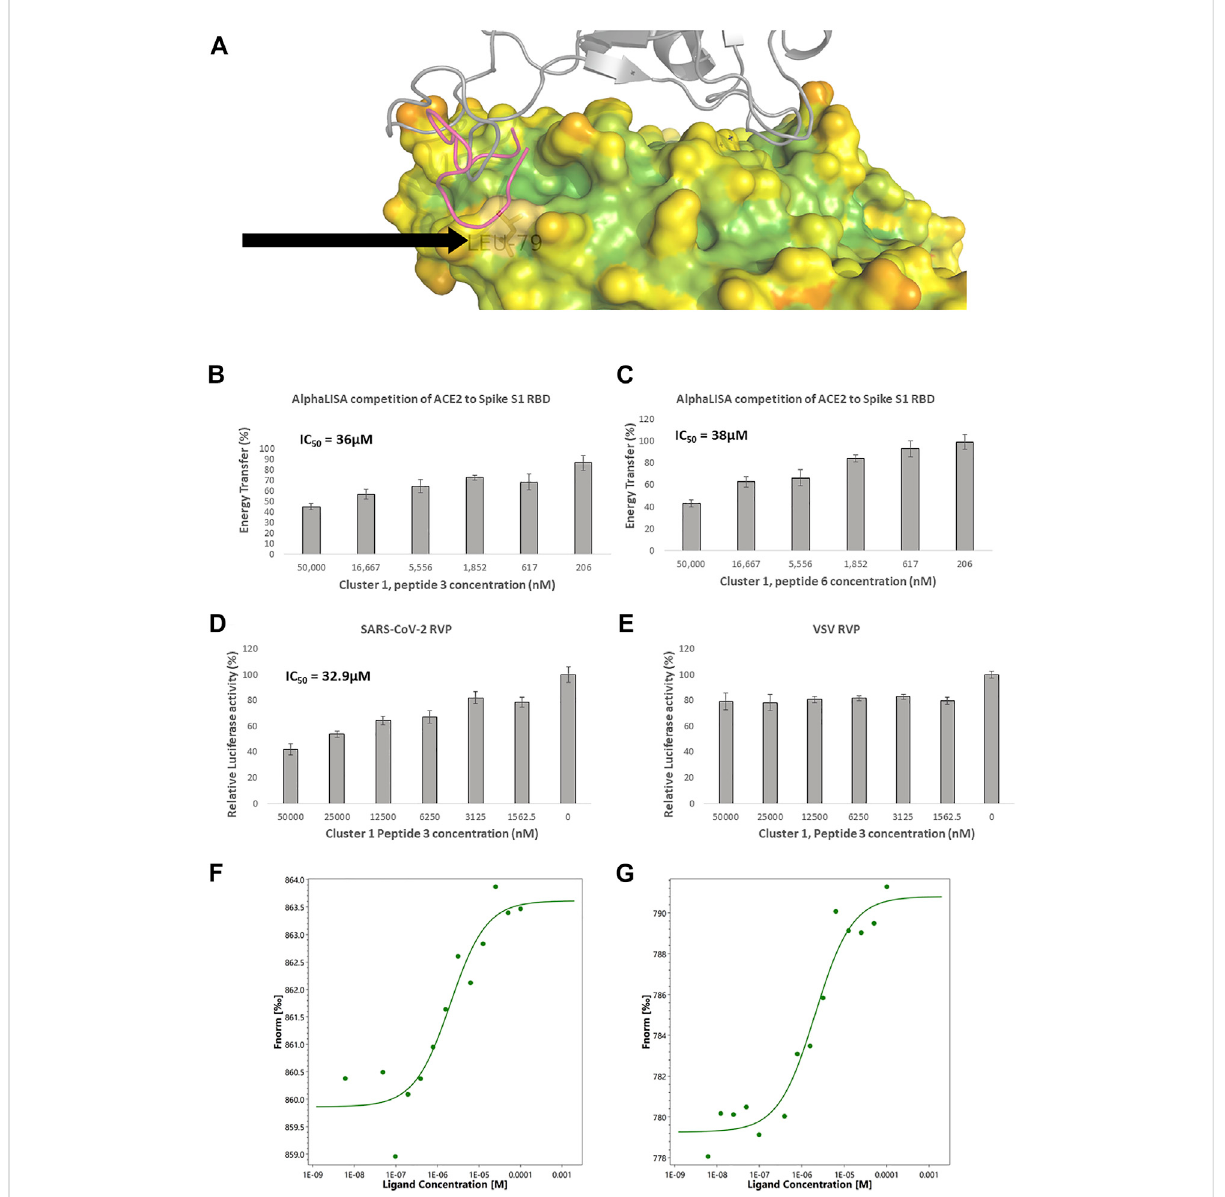
FIGURE 2 Competitive ACE2 targeted screening. (A) A heat diagram analysis of RBD surface concavity (PDB: 6VW1, chain A), (blue = concave, red = convex), spike RBD is shown as a grey cartoon. Leucine 79, chosen as the center of the screening grid, is shown with the black arrow. Cluster 1, peptide 3 docking model is shown as purple cartoon. AlphaLISA analysis was used to detect the interaction between the spike protein and the hACE2 receptor. Characterization of inhibitory effect on the interaction between spike and hACE2 proteins. IC50 was calculated for (B) Cluster 1,peptide3and (C) cluster1peptide6( n =2biologicalreplicates,3technicalreplicatesperexperiment,standardmeanerror(SEM)isrepresentedfor each concentration) SARS-CoV-2 and control lentivirus were incubated with Cluster 1, peptide 3 and cells stably expressing human ACE2 in low serum media. After 24 h the media was replaced with fully supplemented media for additional 48 h (D) Inhibitory effect on the infection of SARS- CoV-2 lentivirus in 6 concentrations are presented. n = 1 (3 technical replicates) (E) Inhibitory effect on the infection of control lentivirus in 6 concentrations are presented. n = 1 (3 technical replicates) for VSV. IC 50 is calculated. The standard mean error (SEM) is represented for each concentration. Micro Scale Thermophoresis (MST) was used to analyze ACE2 binding (F) Cluster 1 peptide 3, shows a dissociation constant (Kd)